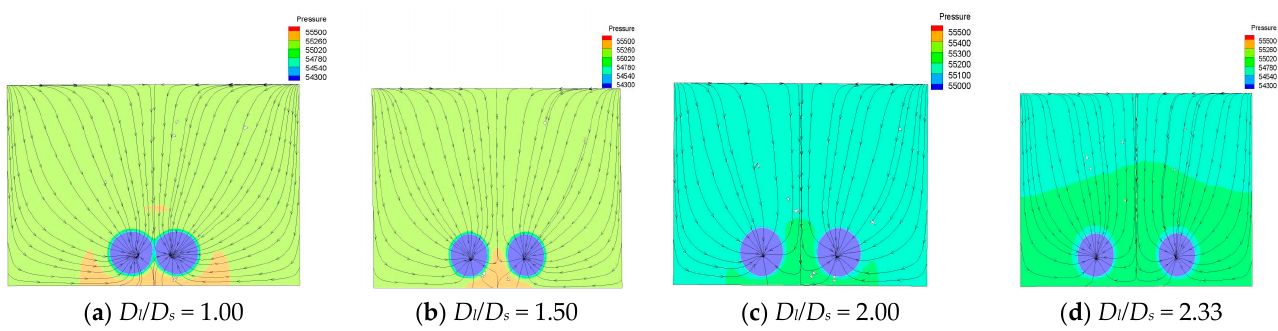
Figure 17. Suction sump pressure and flow line distribution (section 3 - 1, unit: pa).